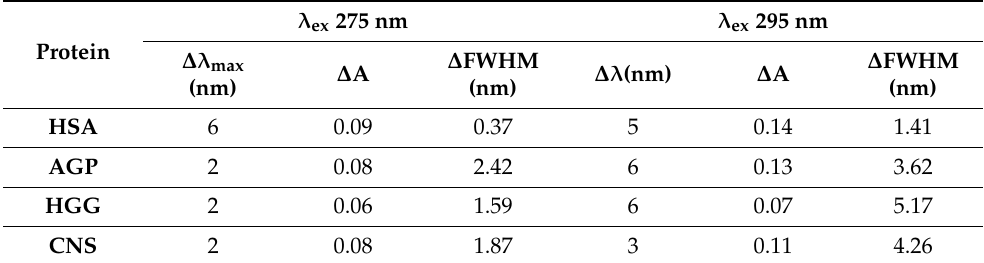
Table 2. Concentrations (mol · L − 1 ) at the excitation wavelengths λ ex 275 nm and λ ex 295